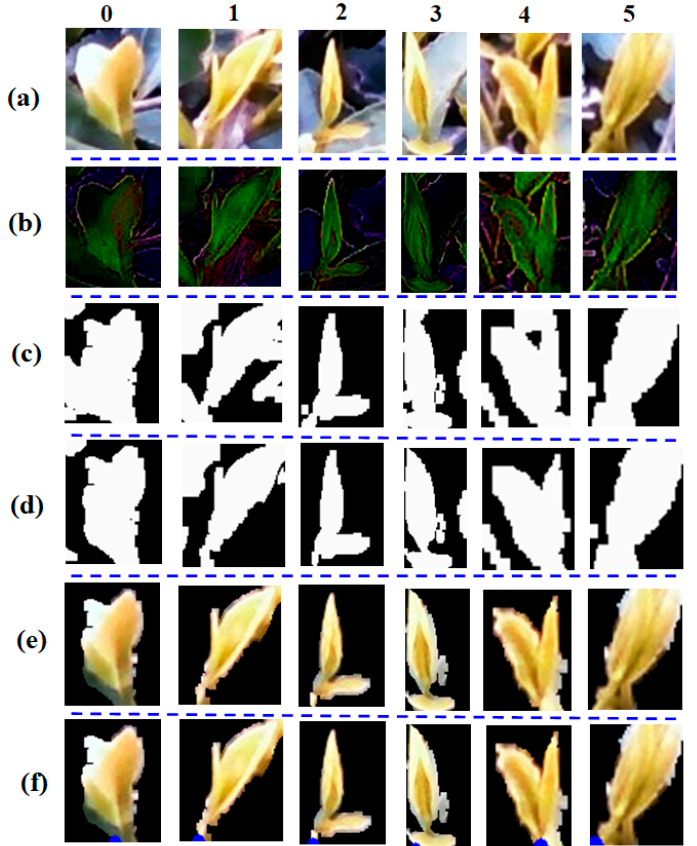
Figure 13. Detection and segmentation of tea buds and localization of picking points. ( a ) Cropped sub-image by the object detection model; ( b ) Preprocessed image; ( c ) Segmented image; ( d ) Depth filter; ( e ) Masked color image after size filtering; ( f ) Localization of picking points as the lowest pixel of each contour.